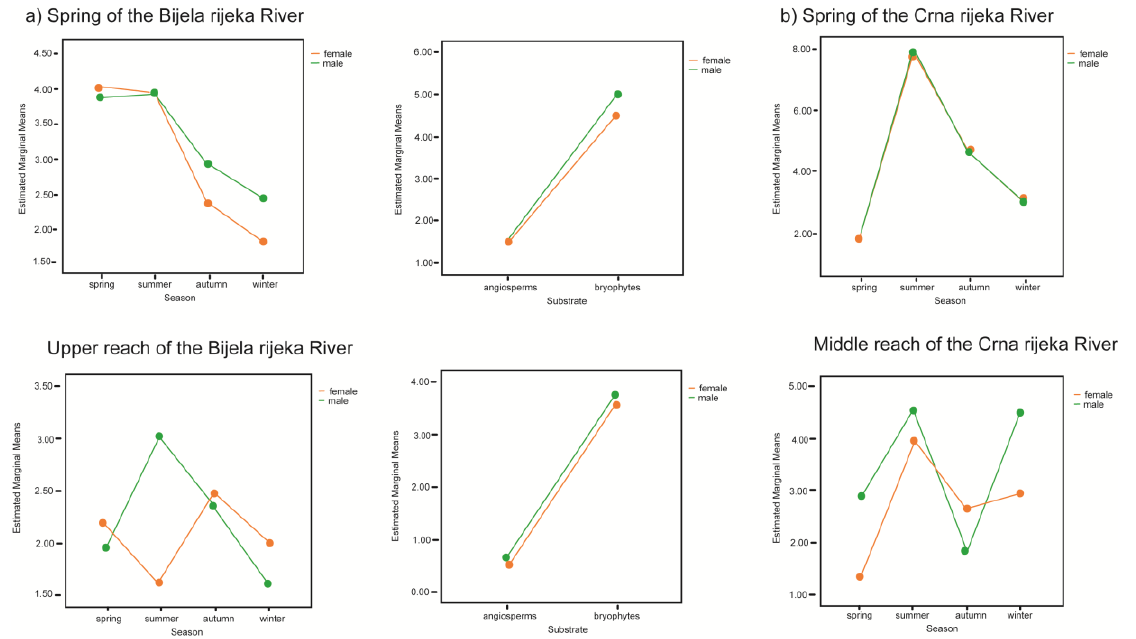
Figure 8. Univariate analysis profile plots of sex ratio of E. bosnica (Zaitzev, 1908), in two rivers in Croatia: ( a ) by season and substrate in the Bijela rijeka River and ( b ) by season in the Crna rijeka